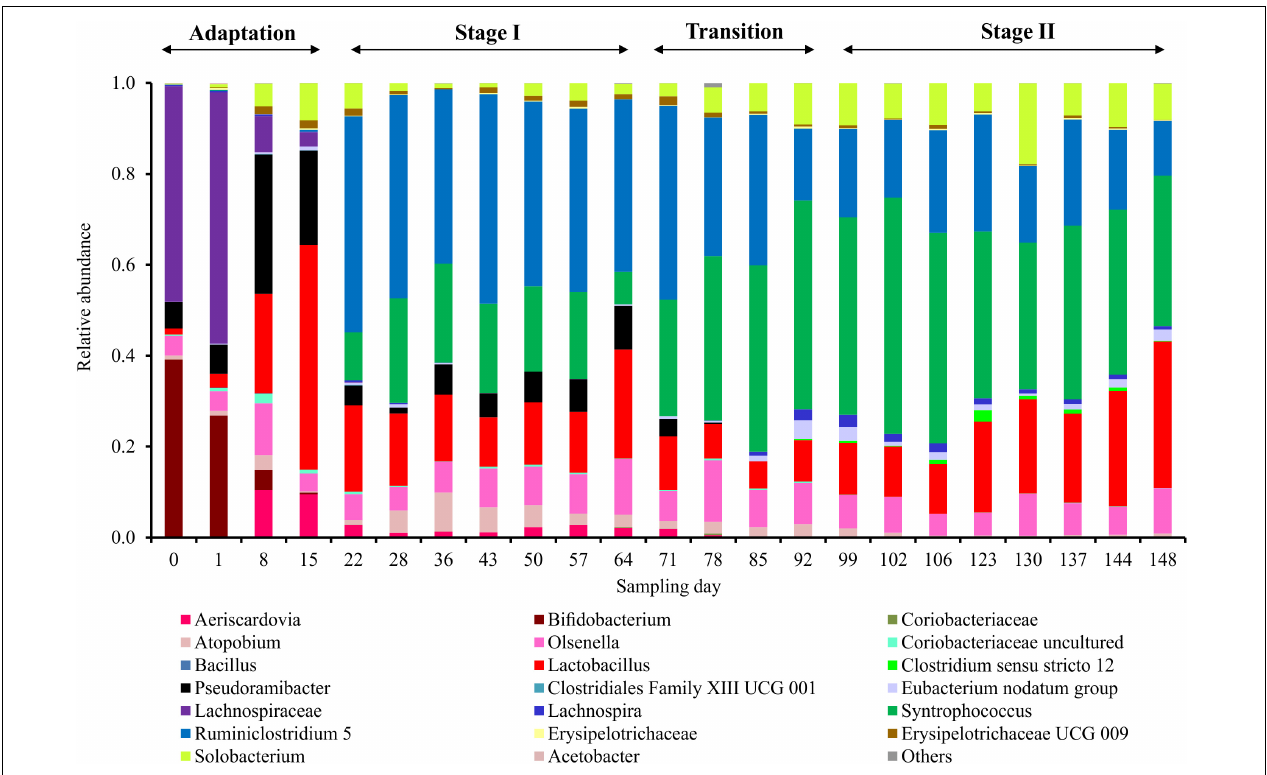
FIGURE 3 | Microbial community composition profiles in the four succession stages based on amplicon sequencing of 16S rRNA genes. Taxonomic classification of amplicon sequence variants (ASVs) was categorized at the genus level. ASVs with relative abundance lower than 0.1% are classified into “Others.”